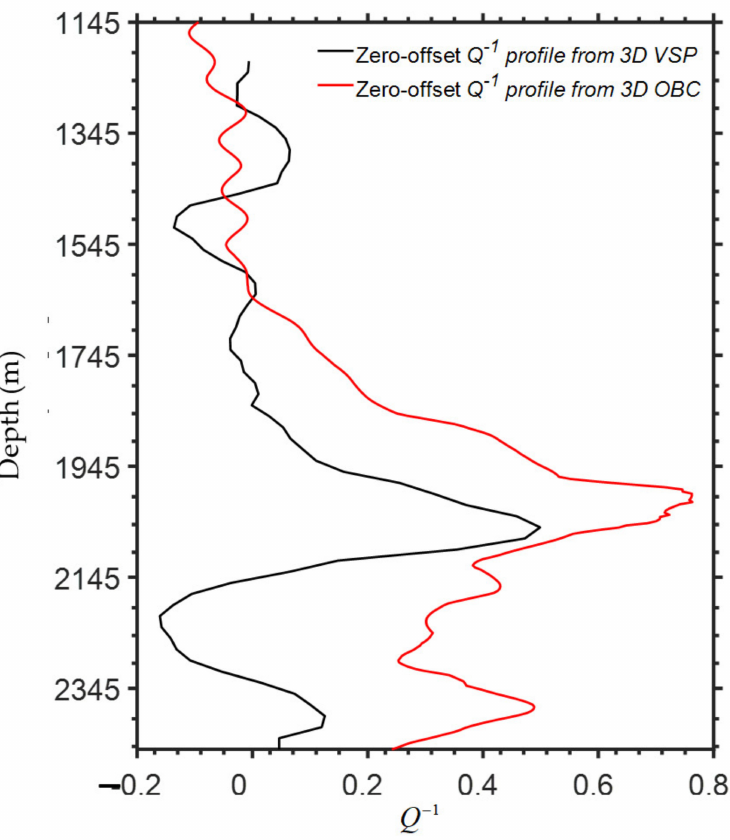
Figure 10. Zero offset Q − 1 profiles obtained from 3D VSP data (black) and from a linear fitting of Q − 1 estimated from 3D OBC seismic data (red), generated by the closest shot (the green star in Figure 5) to the wellhead (the black triangle in Figure 5) and recorded by hydrophones that have the smallest offsets (the red dots in Figure